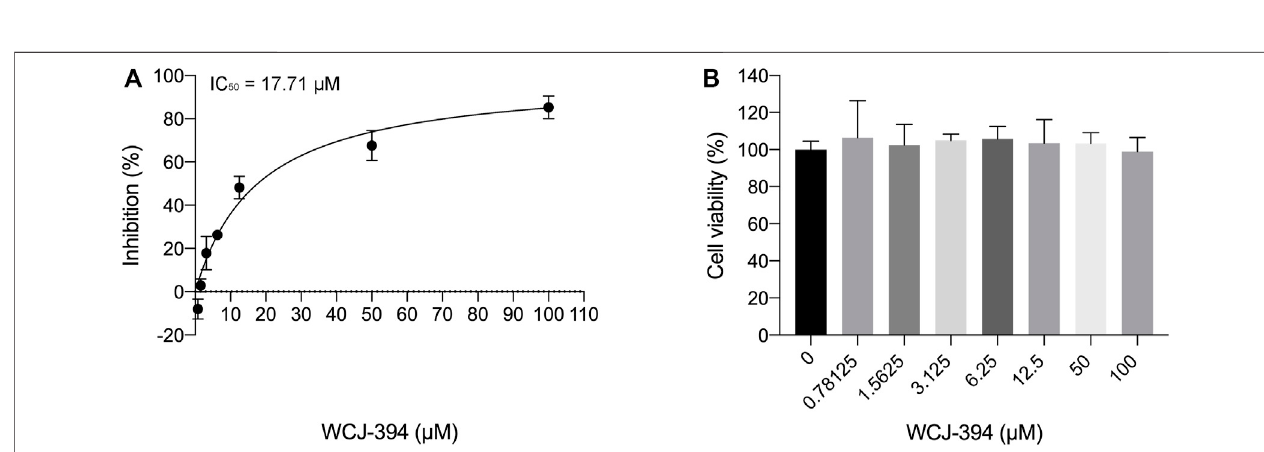
FIGURE 3 | The inhibitory effect of WCJ-394 on the TGF- β signaling pathway. (A) Inhibition of WCJ-394 on the TGF- β signaling, IC 50 = 17.71 μ M. (B) Effect of WCJ-394 on MLEC cell viability in the same condition.